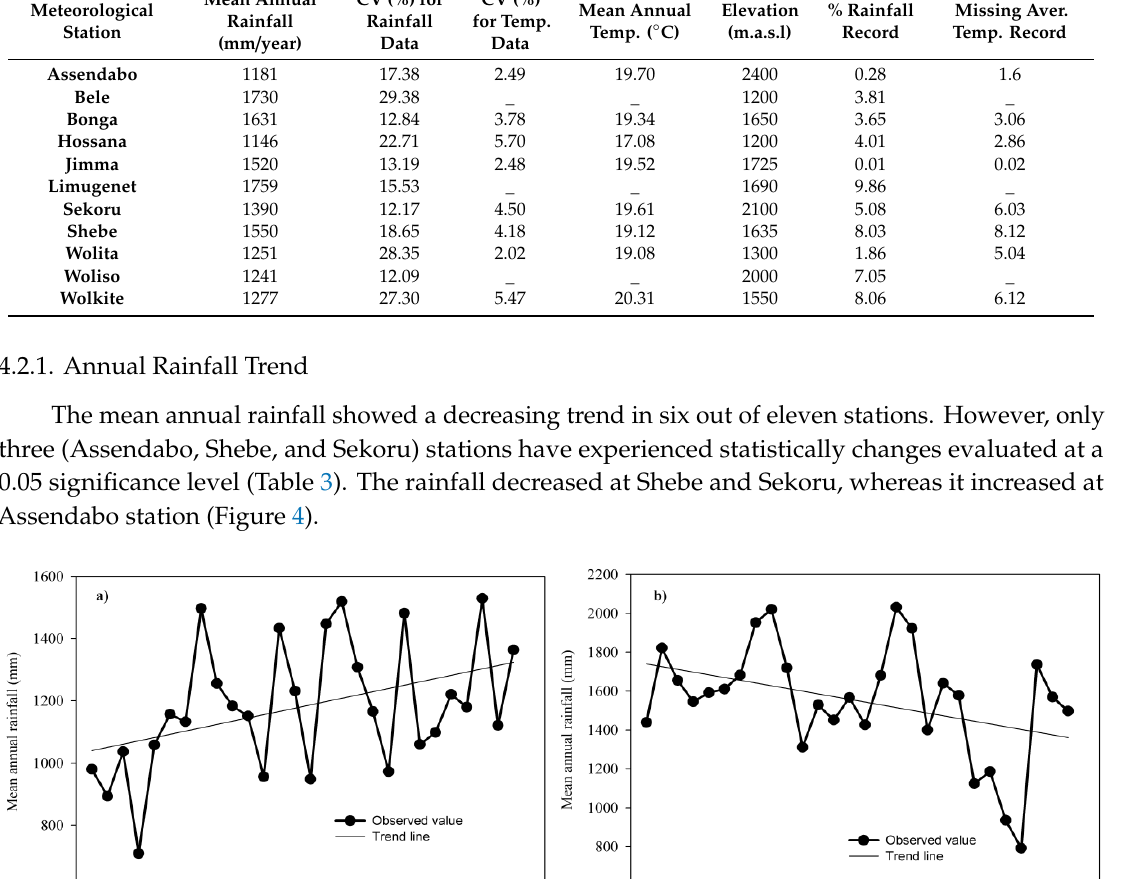
Table 2. Description of the meteorological stations in the upper Omo-Ghibe basin covering the period 1981–2008.